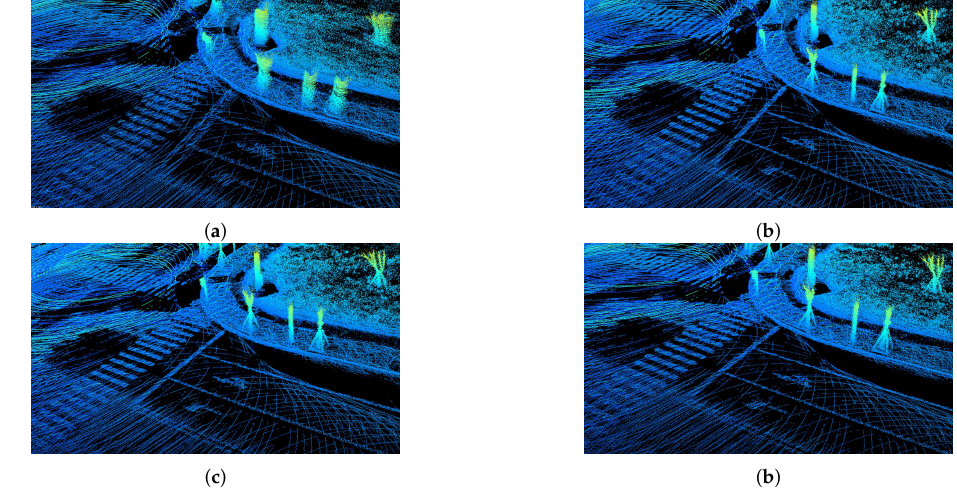
Figure 10. The 3D reconstruction results to test the three rectification methods. ( a ) represents the result without any rectification, and ( b – d ) show the results when the distorted point clouds are rectified by the previous registration result, by registering two distorted point clouds and by the IMU data, respectively.